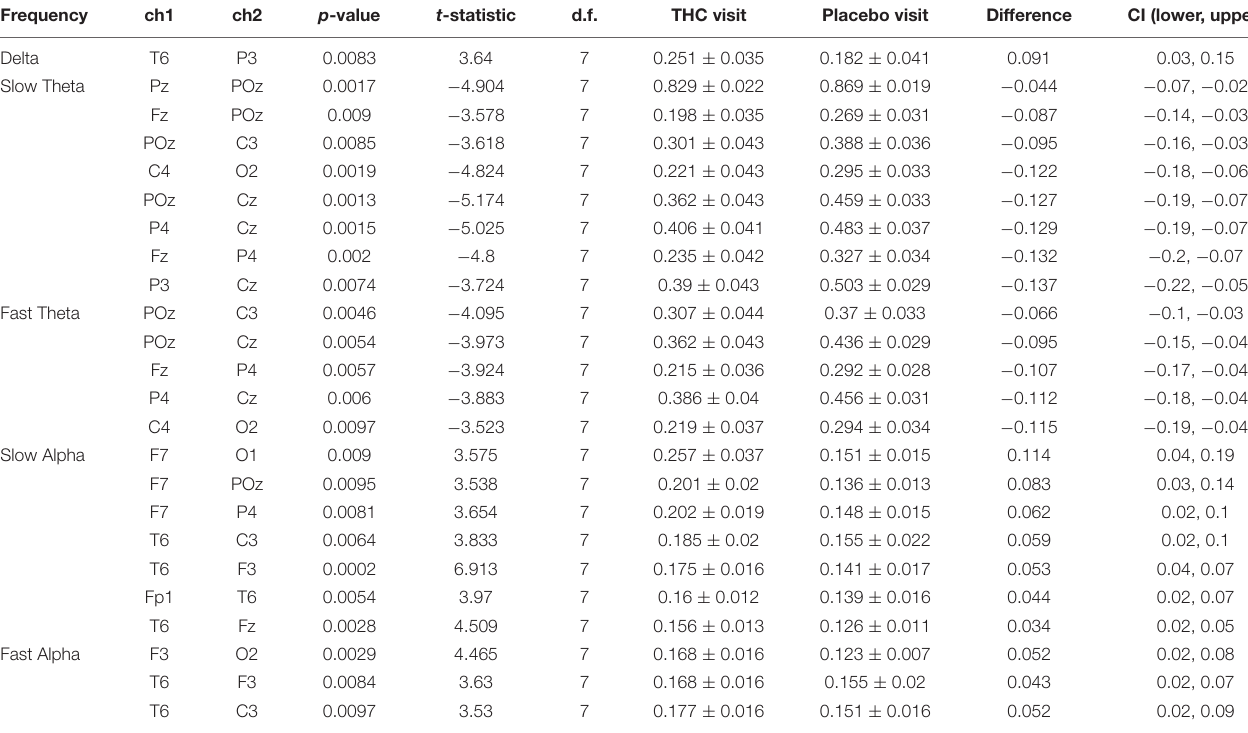
TABLE 7 | Coherence statistics for resting state eyes